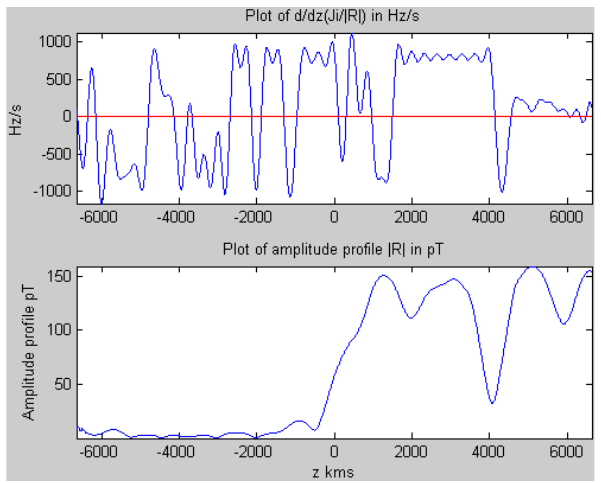
Fig. 14. Snapshot of the term in d/dz(J i /R ) (Eq. 20) in units of Hz/s during a rising element in for the case Ne=5 electrons/cc. The considerable variability is due to the sideband activity permitted within the simulation bandwidth. However, it is seen that the mean value is positive and hence this term is a significant contributor to df/dt .